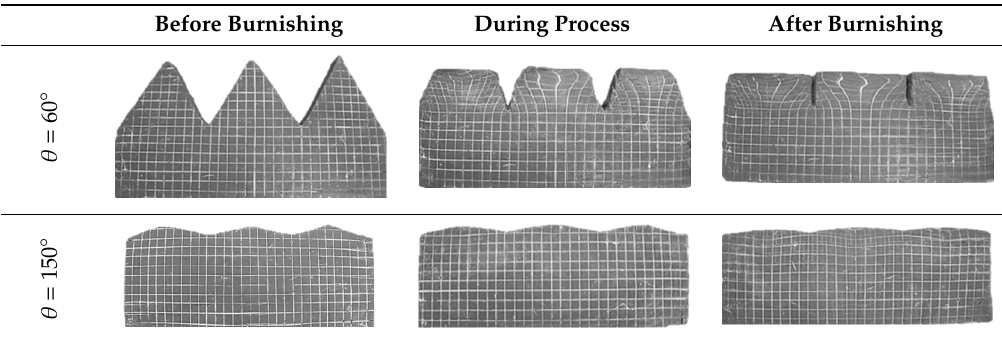
Table 2. View of the exemplary samples.